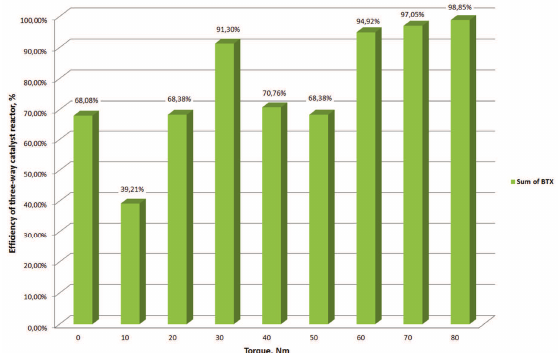
Fig. 6. Effectiveness of analysed aromatic hydrocarbons removal by TWC depending on the torque value